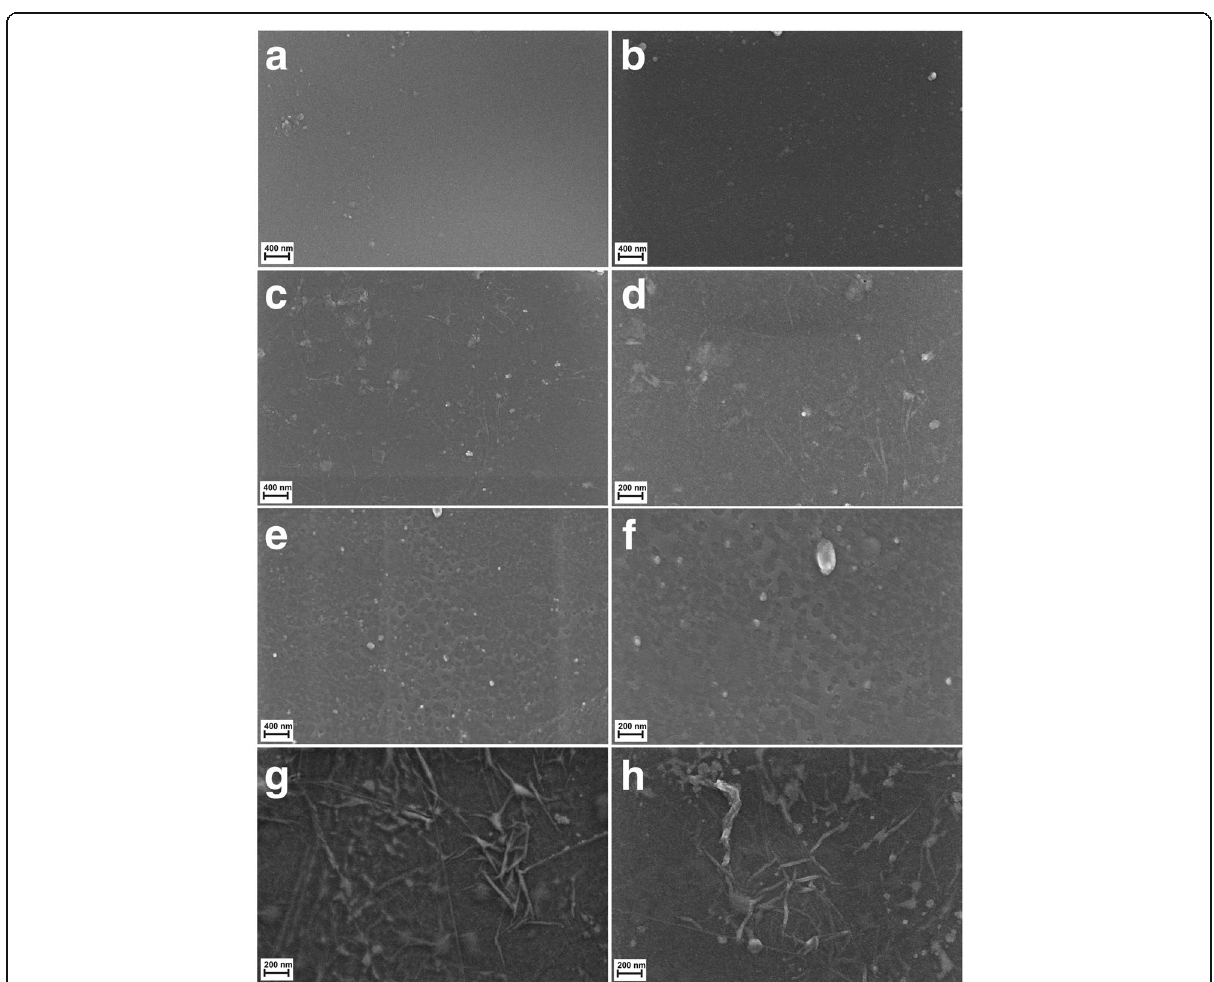
Fig. 7 Scanning electron microscopy images of a , b non-coated polyurethane foil with a smooth surface with single impurities; c , d foil coated with GO, the broken-down GO flakes deposited on the polyurethane foil surface; e , f foil coated with Ag-NPs on which grid structures composed of polyvinyl alcohol and Ag-NPs are observed; and g , h foil coated with GO-Ag, which was mixed under the influence of ultrasounds and deposited on the foil